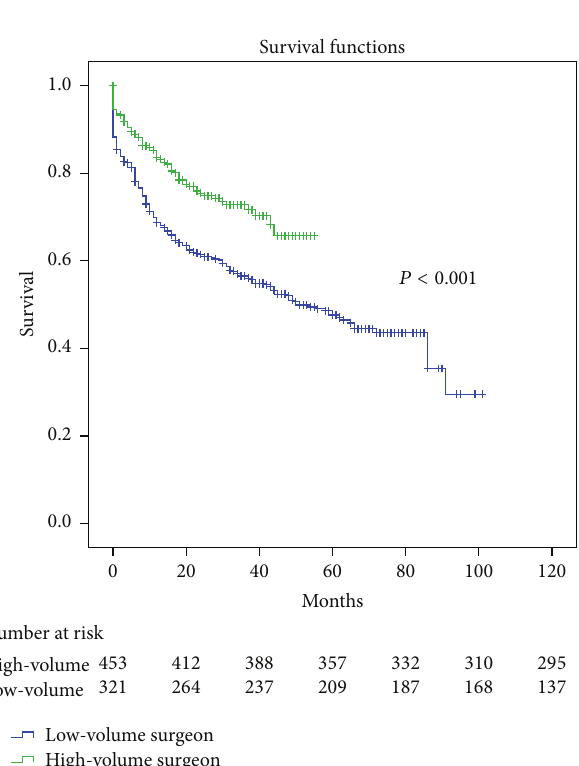
Figure 2: Kaplan-Meier curve for overall survival stratified for surgeon volume. Seventy-five percent of the patients operated on by a high-volume surgeon were alive after a median follow-up of four years, compared to 54% of those operated on by a low-volume surgeon ( 𝑃 < 0.001